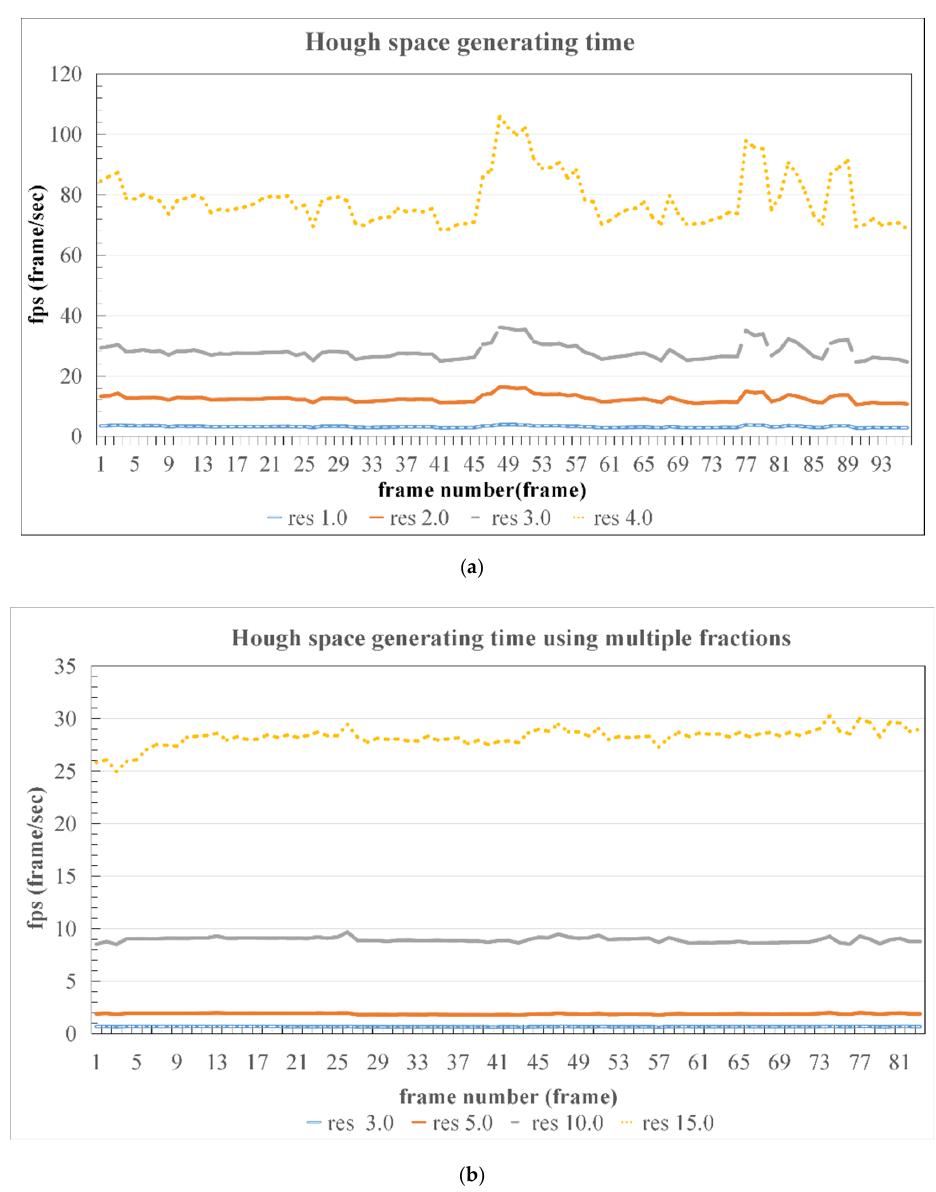
Figure 10. Speed performance and time consumption in generating Hough space. ( a ) The Hough space generating time using all of the point clouds. ( b ) The Hough space generating time using multiple fractions.